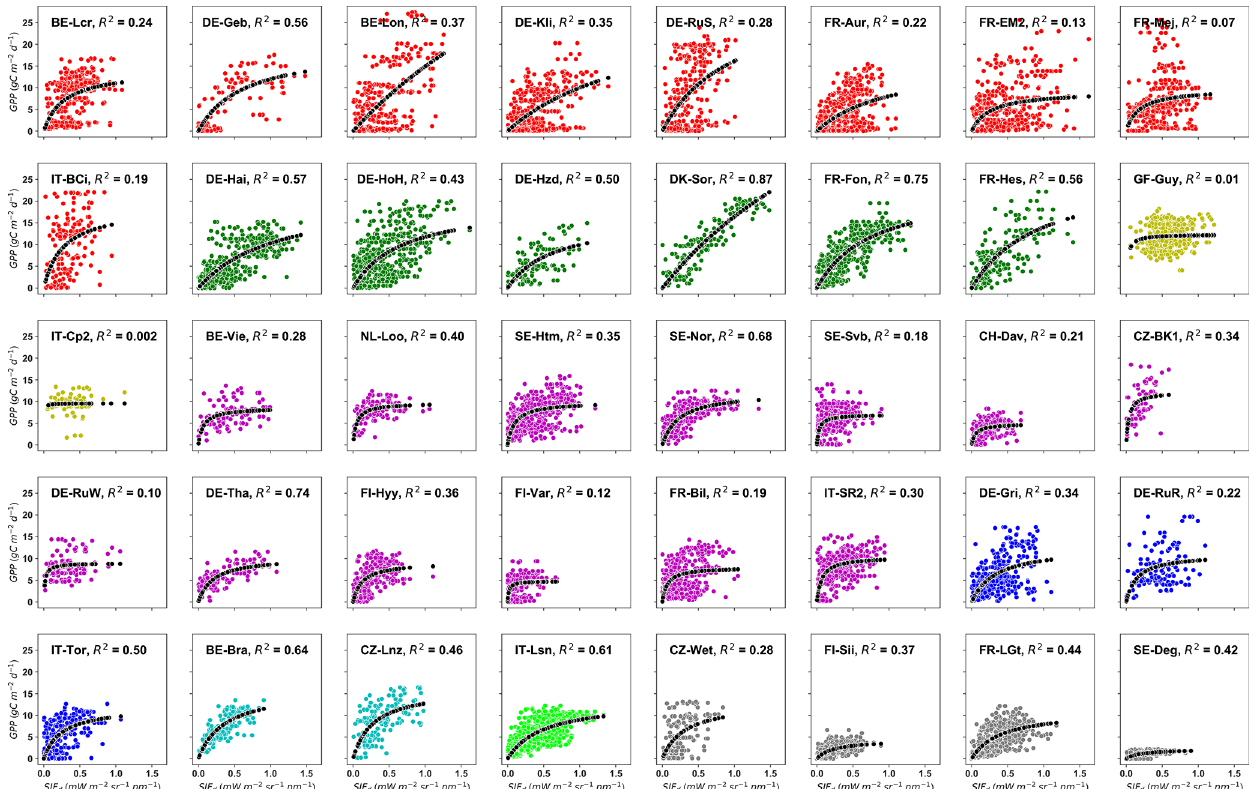
Figure 2. Site-specific tower-based GPP and SIF d relationships at daily timescales. R 2 represents the coefficient of determination of the relationship between GPP and SIF d for each site. The color code represents the eight different plant functional types encountered at the study sites: red stands for croplands (CROs), green for deciduous broadleaf forests (DBFs), yellow for evergreen broadleaf forests (EBFs), magenta for evergreen needleleaf forests (ENFs), blue for grasslands (GRAs), cyan for mixed forests (MFs), lime for open shrubland (OSH), and dim-grey for wetland (WET). The dotted black line represents the hyperbolic fit between GPP and SIF d . Plant-functional-type-specific and overall site relationships.